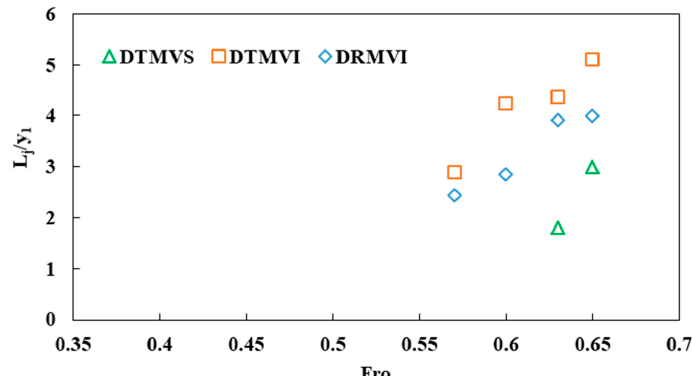
Figure 9. Relative length of hydraulic jump in HDS.